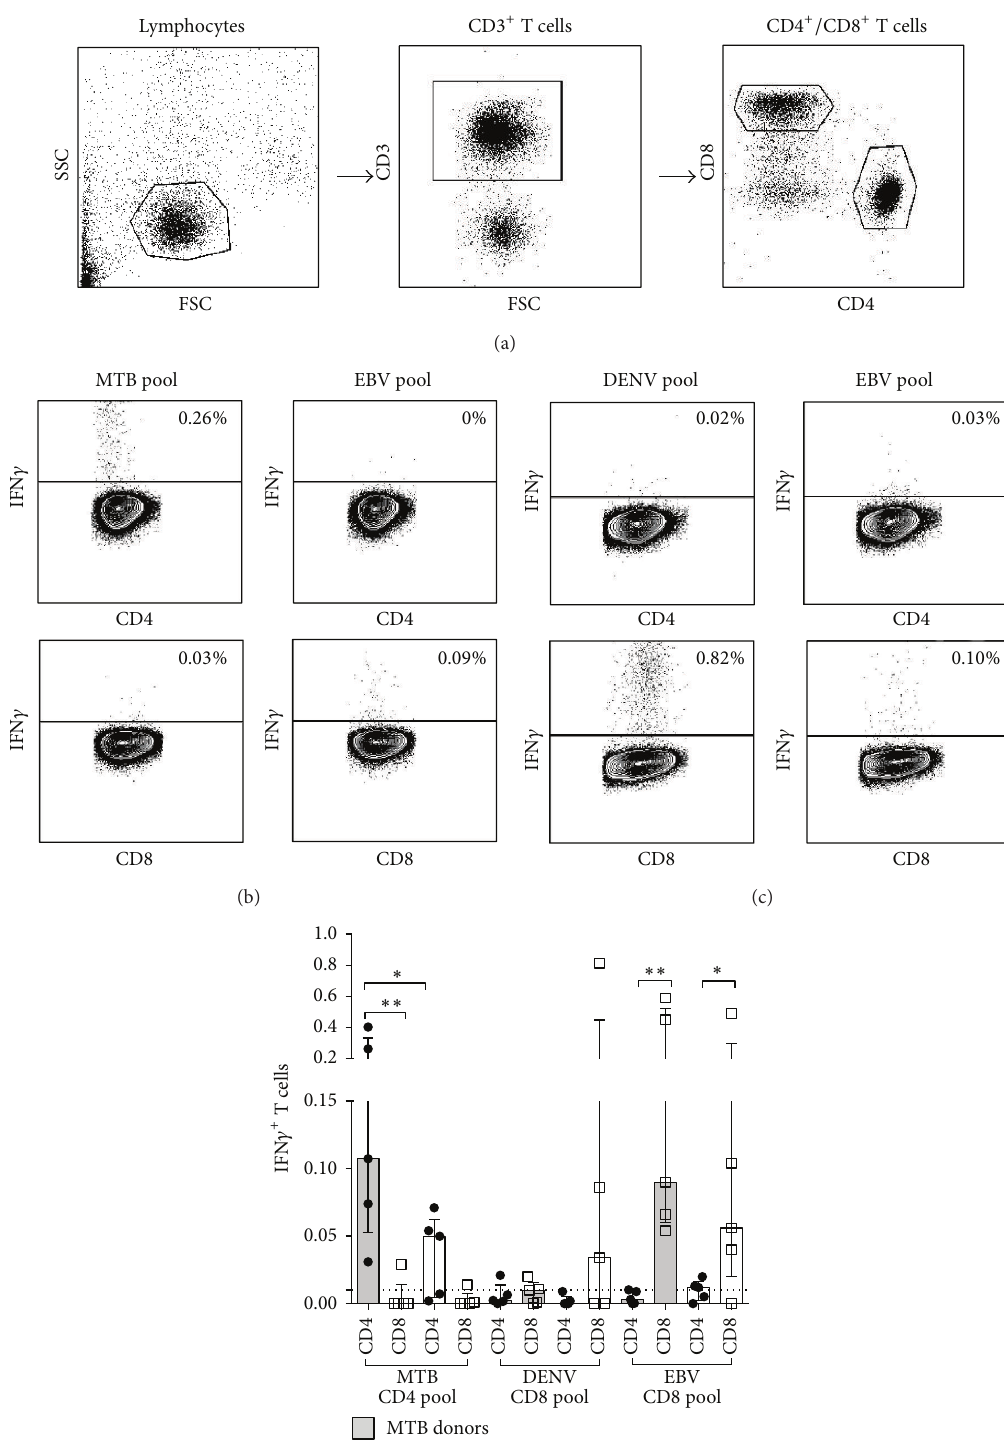
Figure 3: Predicted epitope pools induce a detectable ex vivo cytokine response. PBMC from donors with LTBI (MTB donor) or previously exposed to DENV were stimulated with their respective epitope pools and an EBV epitope pool. After ex vivo stimulation, the IFN 𝛾 response was measured by ICS using flow cytometry. Gating strategy (a) and representative plots of the responses for both CD4 + and CD8 + T cells are shown for a MTB donor (b) and DENV donor (c). (d) The ICS IFN 𝛾 responses induced by each epitope pool for all donors tested are summarized ( 𝑛 = 10 ). Statistical difference was determined using a one-tailed Mann-Whitney test. ( ∗ 𝑃 ≤ 0.05 ; ∗∗ 𝑃 ≤ 0.01